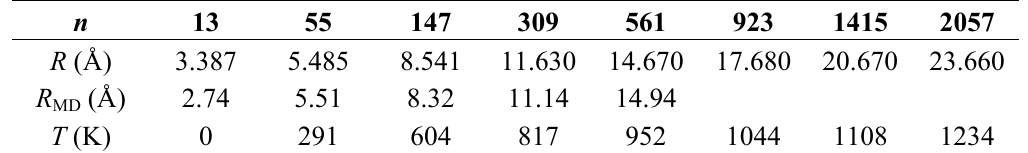
Table 4. The Ag supercluster radii with magic atom numbers. The radius R is deduced from molar volume V and equal to critical radius R * m For T > T /3 = 411.33 K, the energy saving coefficient ε m ε = 0.217 and ( θ ) − 2 = 2.25. For T < 411.33 K, ε ls0 0m from molecular dynamics simulations [5].